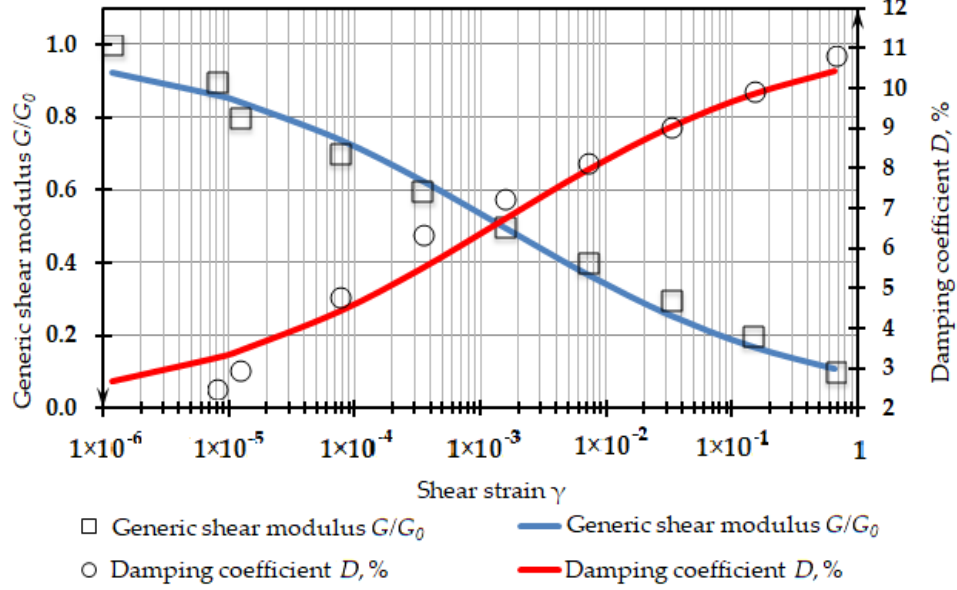
Figure 5. Approximated graph of the relationship between generic shear modulus G/G 0 (unit fractions) and damping coefficient (%) and shear strain amplitude γ (unit fractions) for the soil cement with the Ramberg–Osgood model (results of six